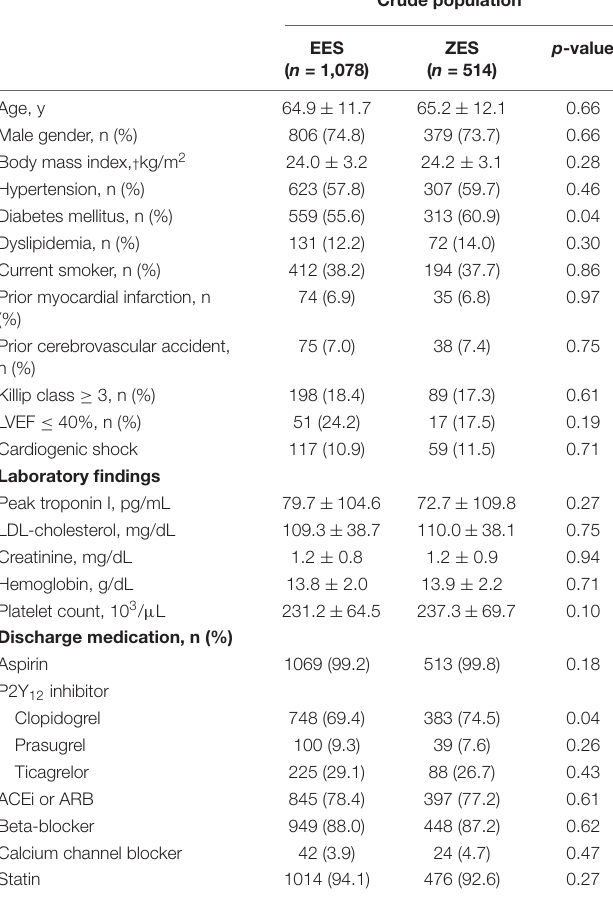
TABLE 1 | Baseline characteristics.